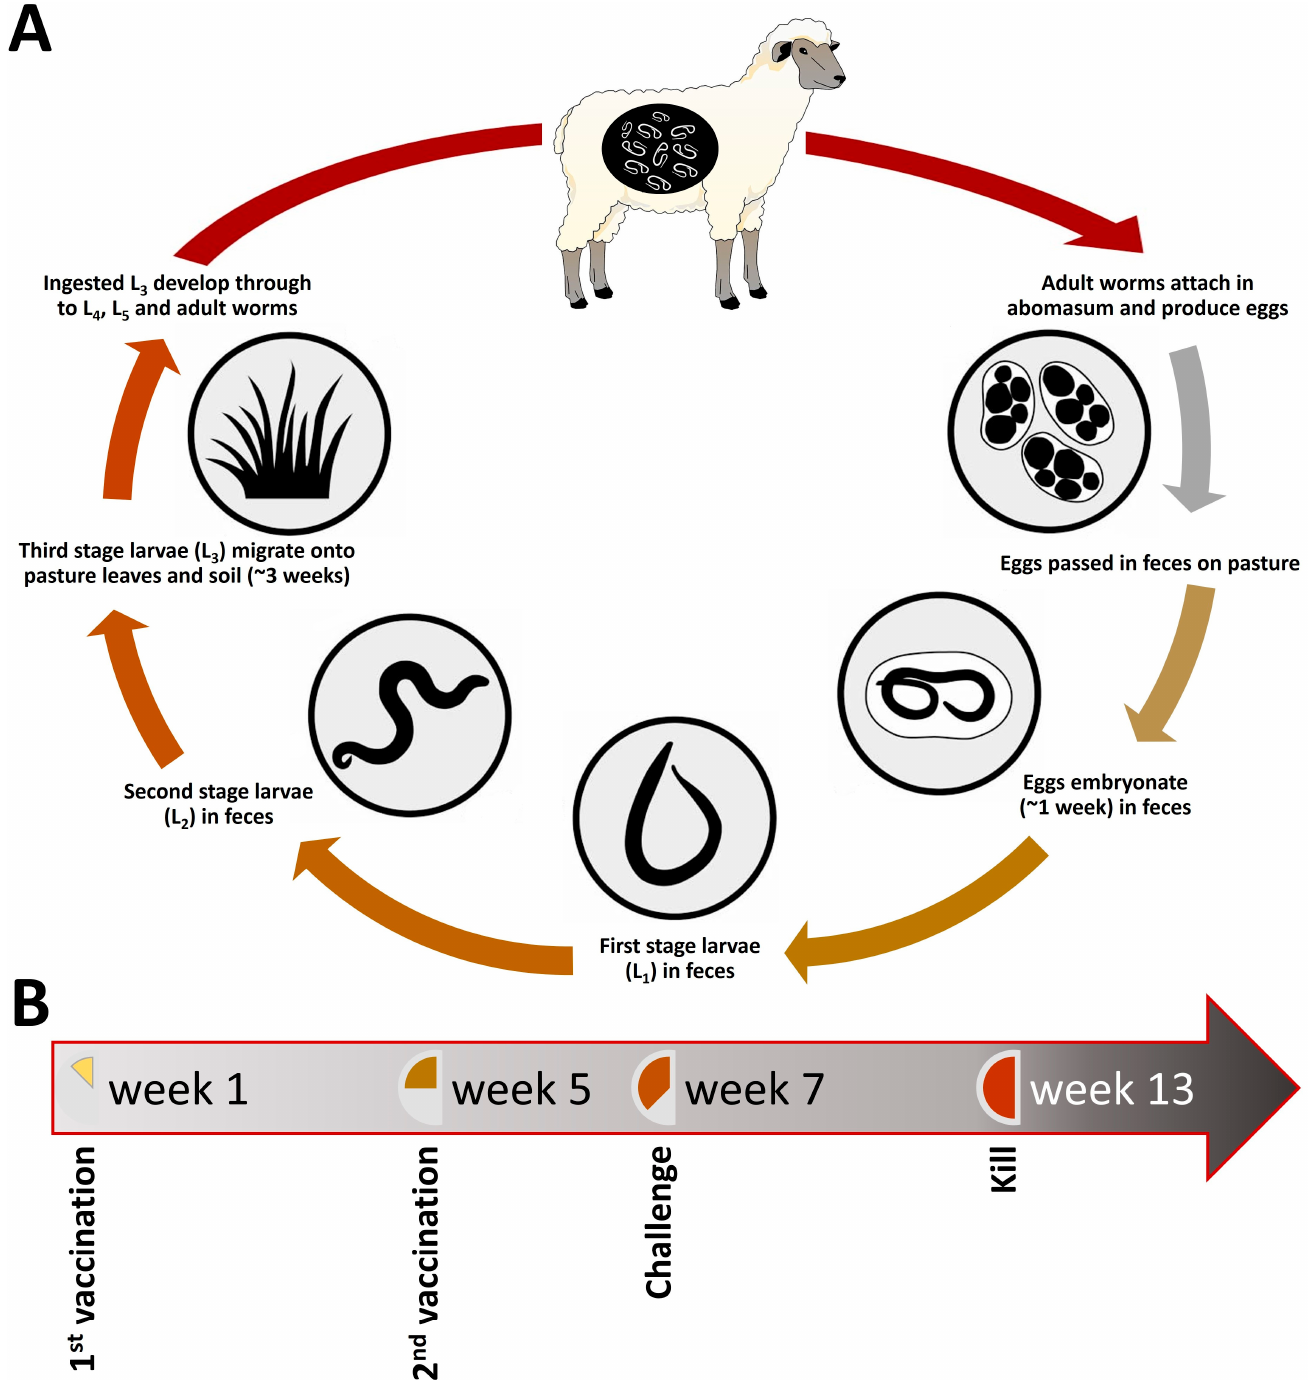
Figure 1. Developmental life cycle of Haemonchus contortus parasite in sheep ( A ) and experimental design for parasite sample collection ( B ). Figure adapted from Palevich et al. [3].